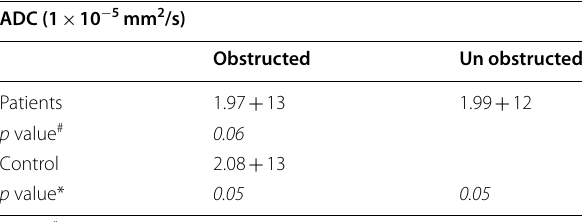
p value # for obstructed against unobstructed p value* control against patient